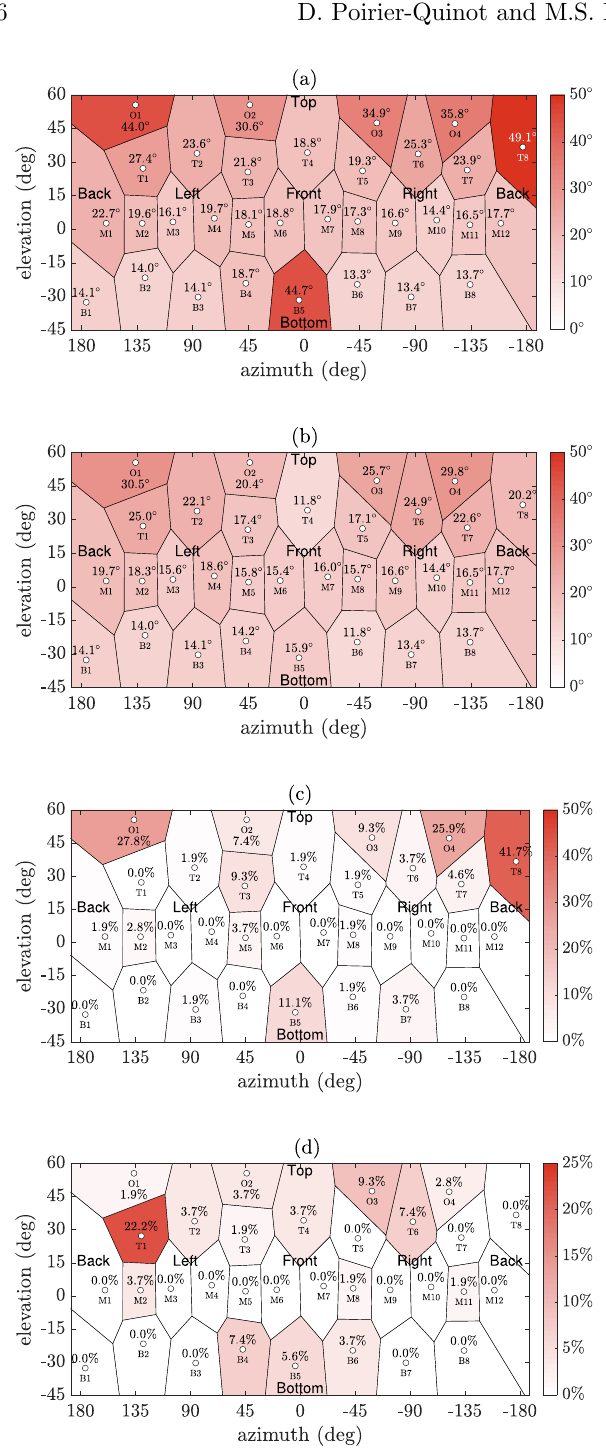
Figure 4. Localization performance across speaker positions, depicting (a) great circle angle error, (b) local great circle angle error, (c) front – back confusion rate and (d) up – down confusion rate for the No HMD condition. Metric values are reported above each speaker position (white circles), around which Voronoi cells have been drawn to simplify results interpretation. The apparent cell structure asymmetry is a result of the projection mapping inducing distortion at the poles (near ±90 (cid:1) elevation).